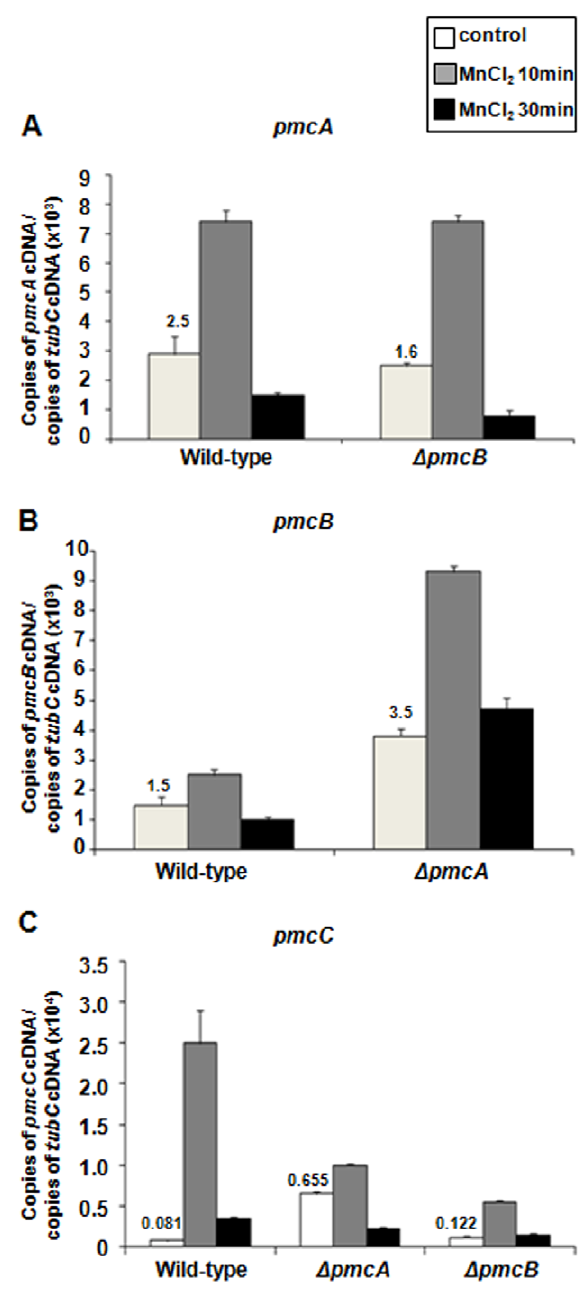
Figure 7. The pmcA-C genes have increased mRNA abundance when exposed to manganese. The absolute quantitation of pmcA , pmcB , and pmcC and tubulin gene expression was determined by a standard curve (i.e., C T –values plotted against a logarithm of the DNA copy number). The results are the means ( 6 standard deviation) of four biological replicates. (A–C) The mRNA abundance of pmcA-C in the wild- type, D pmcA , and D pmcB . doi:10.1371/journal.pone.0037591.g007 same time points (reference treatment) (Table 1). All these three genes showed, to different extents, decreased mRNA abundance during the initiation of murine infection by the A. fumigatus D calA and D crzA mutant strains relative to the wild-type strain. Thus, it seems that in vivo pmcA-C mRNA accumulation is dependent on CalA and crzA .